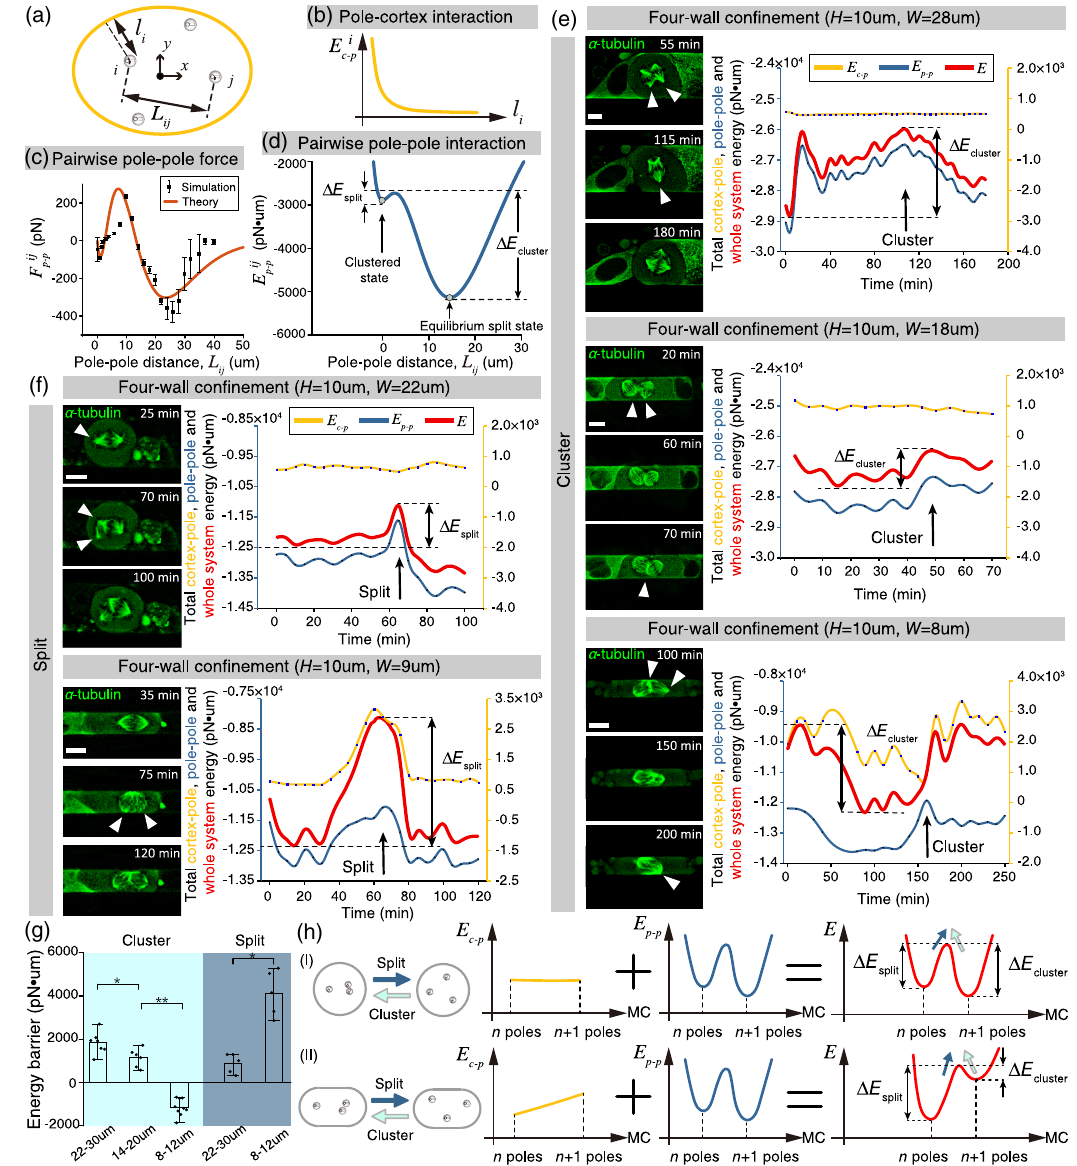
FIG. 5. Enhancement of pole clustering and inhibition of pole splitting under four-wall confinement induced by the pole-cortex interaction mediated by cell shape. (a) Schematic of the theoretical model. (b) Pole-cortex interaction between the i th pole and the cortex, E i c − p , becoming more repulsive when the pole approaches the cortex and rapidly diminishing when the pole moves far away from the P n E i cortex. Note that l i is the minimum distance between the i th pole and the cortex. Here, E c − p ¼ c − p denotes the total pole-cortex i ¼ 1 interaction. (c) Pairwise pole-pole interaction force between the i th and the j th poles, F ij p − p , as a function of pole-pole distance L ij , calculated in our simulation and fitted by the theoretical model. (d) Pairwise pole-pole interaction energy between the i th and the j th poles, E ij p − p , which is a double-well potential with two stable states, i.e., the clustered and split states. Total pole-pole energy landscape of multiple P n E ij E poles, i.e., E p − p ¼ p − p . (e,f) Calculated time evolution of the pole-pole interaction energy ( p − p ), pole-cortex interaction energy i;j ¼ 1 ( E c − p ), and whole energy of the system ( E ¼ E p − p þ E c − p ) during pole clustering and splitting in microchannels with different widths based on the experimental data. The scale bar is 10 μ m. (g) Energy barrier of pole clustering ( Δ E ) and splitting ( Δ E ) obtained from cluster split experiments ( n ¼ 7 , 6, 9, 5, 5). We use the Mann-Whitney test with (cid:2) p < 0 . 05 and (cid:2)(cid:2) p < 0 . 01 . (h) Mechanical confinement influencing the energy barriers of pole clustering and splitting. In wide channels, all spindle poles are far away from the cell boundary, and the pole-cortex interaction is negligible compared to the pole-pole interaction. In narrow channels, the average distance between poles and the cell cortex is smaller, and the contribution of the pole-cortex interaction becomes significant. Thus, the four-wall mechanical confinement changes the energy landscape of the system by increasing Δ E and decreasing Δ E , indicating that it is easier for pole clustering but more difficult split cluster for pole splitting in narrower channels. MC stands for multipolar